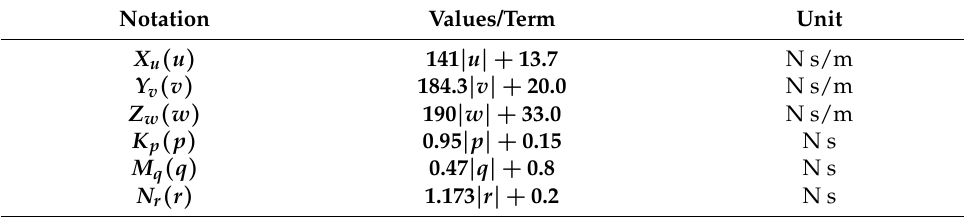
Figure 7. Drag force from flow simulation and corrected 2nd-order polynomial for drag. Table 6. Drag terms used in this study, with refitted Y v ( v ) , K p ( p ) and N r ( r )